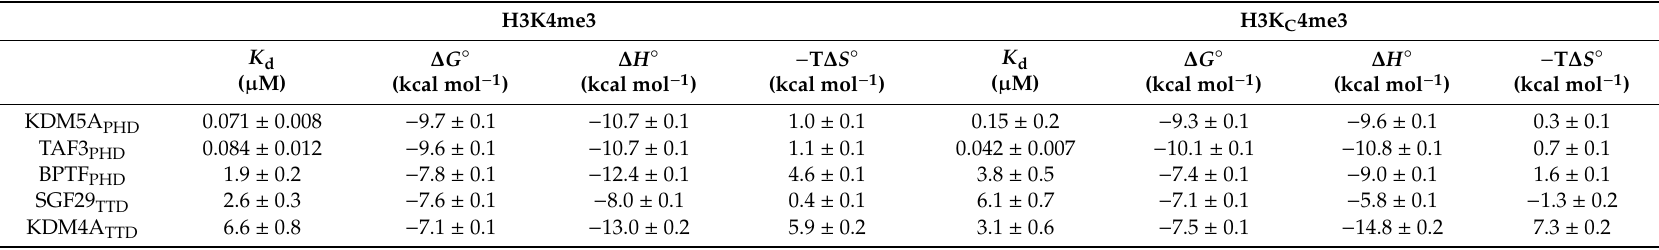
Table 1. Thermodynamic parameters for association of the 10-mer H3K4me3 and H3K C 4me3 peptides (ART(Kme3 / K C me3)QTARKS) with epigenetic reader proteins (values and errors were obtained from 3–5 repeated ITC experiments carried out at 298.15